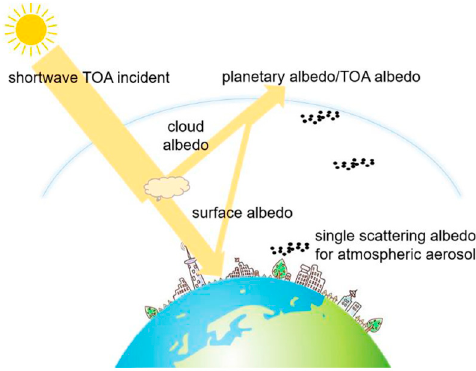
Figure 1. The scenario for several essential albedo variables. In the field of remote sensing, a recent rigorous definition of surface albedo is provided by [8]: “Surface shortwave broadband albedo represents the surface hemispheric reflectivity integrated over the solar spectrum (0.2–5 µ m)”. In the following discussion, only surface albedo will be taken into